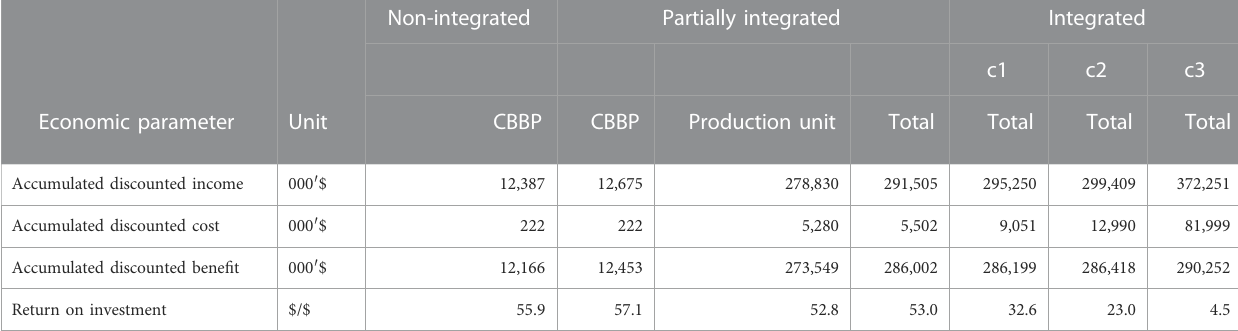
TABLE 5 Financial analysis of three integration scenarios between CBBPs, production units and fattening enterprises. Integration scenarios c1, c2, and c3 involve increasing lamb fattening capacities (see text for a detailed description). Total refer to the sum of CBBP, production unit and fattening